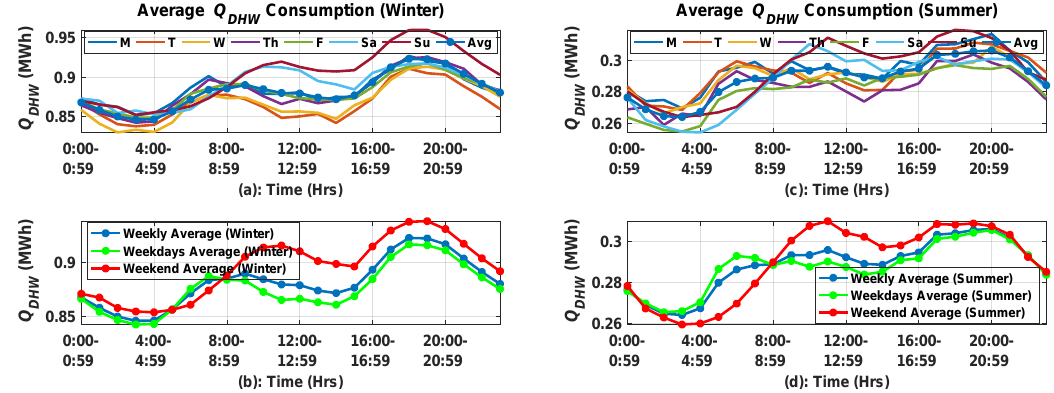
Figure 4. Analysis of Q DHW December 2015–December 2016. ( a , c ) Analysis of average thermal consumption in hourly basis for different days of week for summer and winter respectively. ( b , d ) Analysis of average thermal consumption in hourly basis for a week, weekdays and